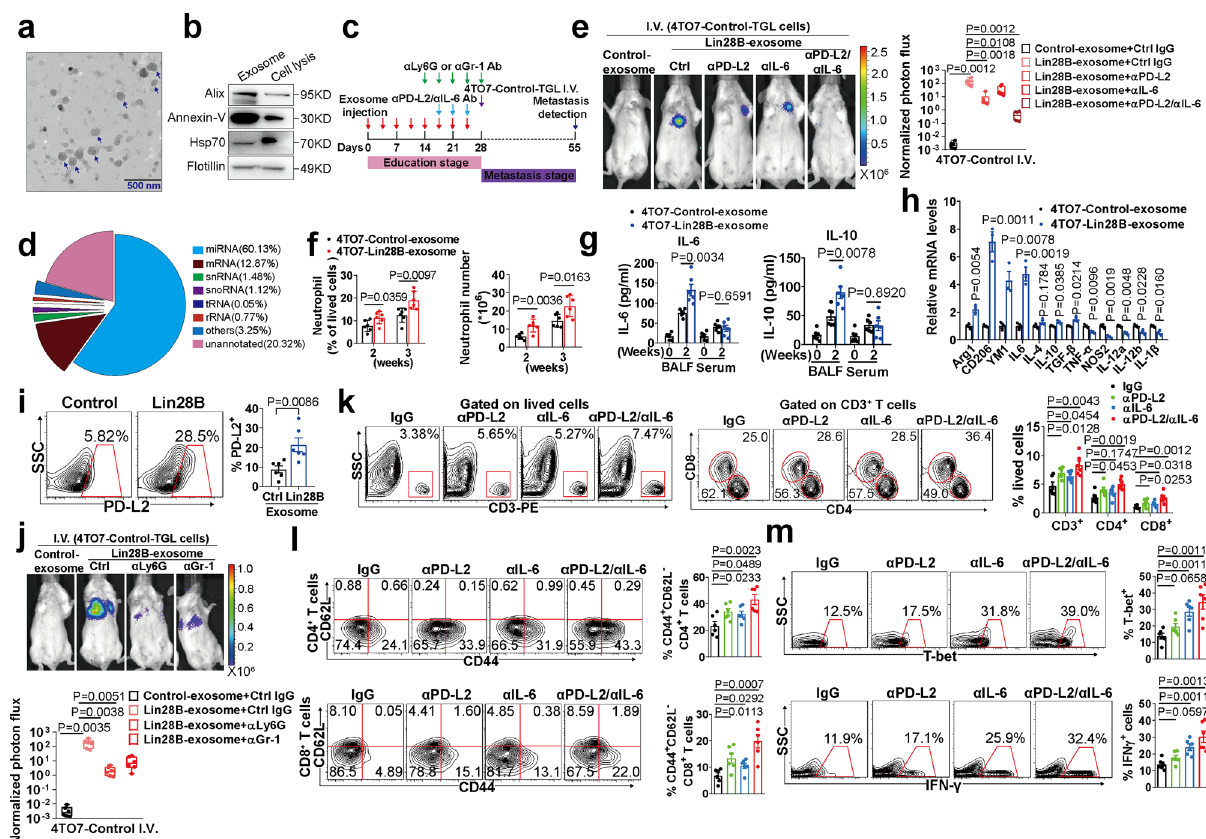
Fig. 6 Exosomes are crucial mediators of Lin28B-induced lung metastasis by creating immune-suppressive pre-metastatic niches. a Representative electron microscopy images of tumor exosomes. The images with saucer-like shapes were represented by a blue arrow. Scale bar: 500 nm. b IB analysis of exosomal proteins. The experiment was repeated three times independently with similar results; data from one representative experiment are shown. c Schematic diagram of exosome education and PD-L2, IL-6, Ly6G, or Gr-1 blocking. d Result summary of small RNA types and proportion from the high- throughput sequencing data of 4TO7 tumor exosomal RNAs. e The experiment was conducted as for panel c . Shown are images and bioluminescence imaging (BLI) quanti fi cation of lung metastasis ( n = 6 mice in each group). f The experiment was conducted as for panel c . Shown are proportions and numbers of neutrophils in the lungs of mice treated with exosomes for 3 weeks ( n = 6 mice in each group). g The experiment was the same as for panel f , except that the IL-6 and IL-10 were quanti fi ed in the BALFs of the treated mice ( n = 6 mice in each group). h The experiment was the same as in panel f , except that the N1/N2 marker genes of lung neutrophils were quanti fi ed by qRT-PCR ( n = 3 mice in each group). i Expression of PD-L2 on lung neutrophils of mice treated with exosomes as for panel f ( n = 6 mice in each group). j The experiment was conducted as panel c . Shown are images and BLI quanti fi cation of lung metastasis ( n = 6 mice in each group). k – m The experiment was conducted as panel c . T cells ( k ), the activated CD44 + CD62L − subset ( l ), and the Th1 subset of the CD4 + T cells ( m ) were analyzed ( n = 6 mice in each group). Data were presented as the mean ± SEM, and p values were calculated using a two-tailed Student ’ s t -test. For panels ( e ) and ( j ), boxes represent data within the 25th to 75th percentiles. Whiskers depict the range of all data points. Horizontal lines within boxes represent mean values. * p < 0.05, ** p < 0.01, *** p < 0.001, ns no signi fi cance. Source data are provided as a Source Data fi